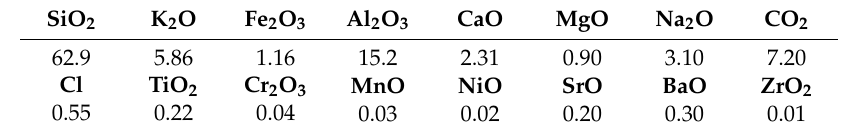
Table 1. Main chemical composition of the tailings (wt. %).